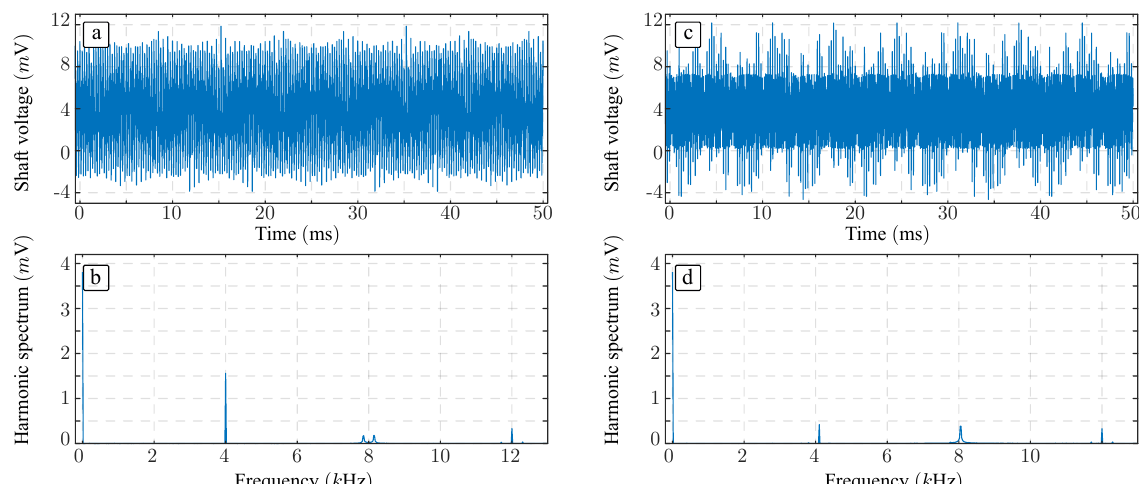
Figure 16. PMSM shaft voltage with rotational speed equal to 250 rpm (corresponding modulation index 0.84) using the PWM method with carrier phase-displacement angles [ φ a , φ b , φ c ] equal to ( a ) [ 0,0,0 ] ◦ ( c ) [ 0, φ b ( b , d ) are their respective harmonic